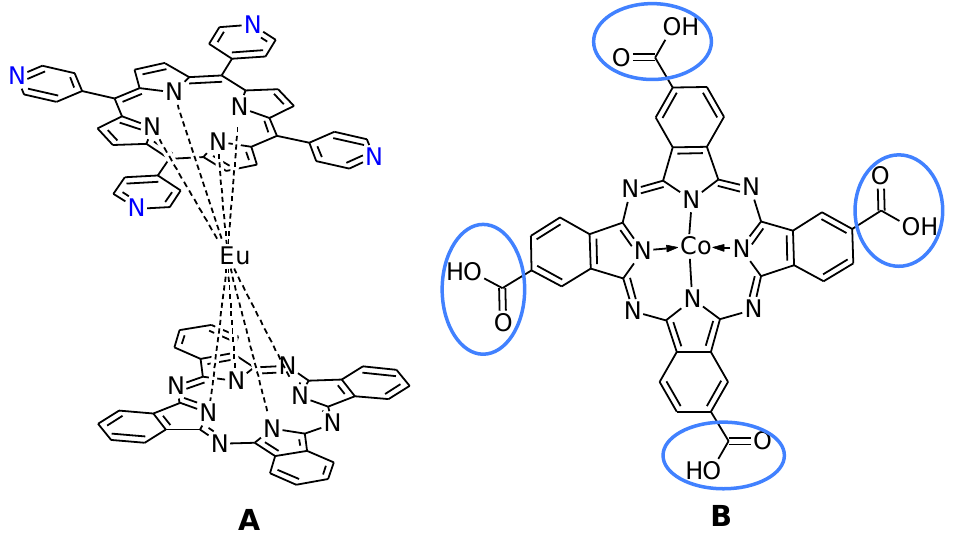
Figure 4. The chemical structure of the sandwich type double decker phthalocyanine/porphyrin europium(II) complex ( A ) [55] and tetracarboxylic cobalt(II) phthalocyanine ( B ) [55].